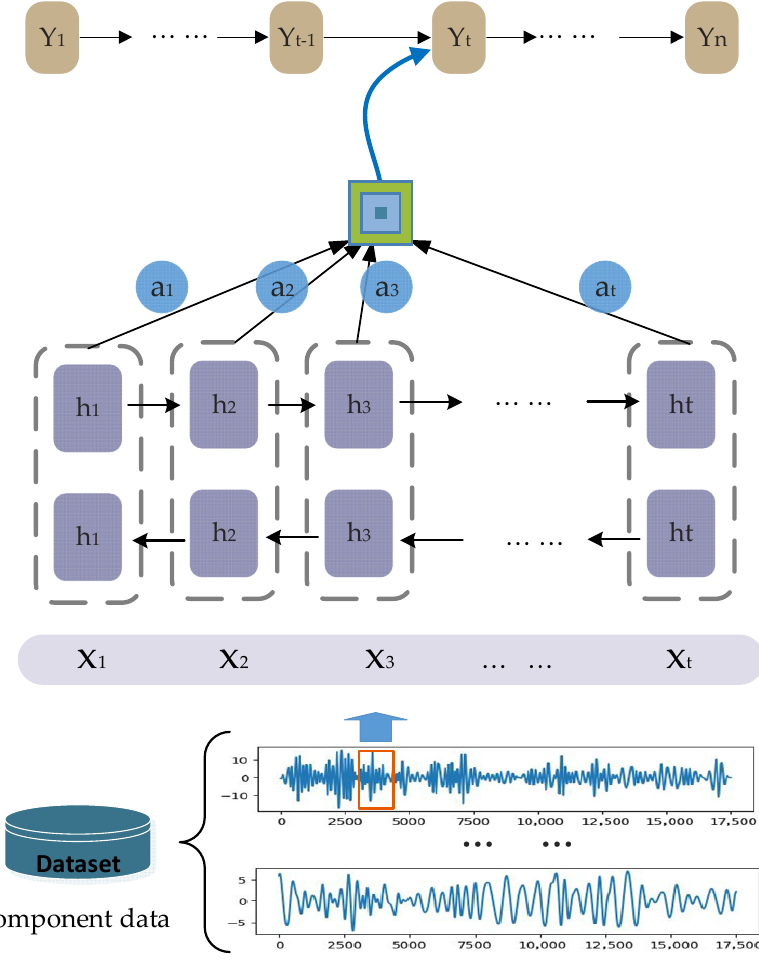
Figure 4. The structure of the Bi-LSTM-Attention Model.